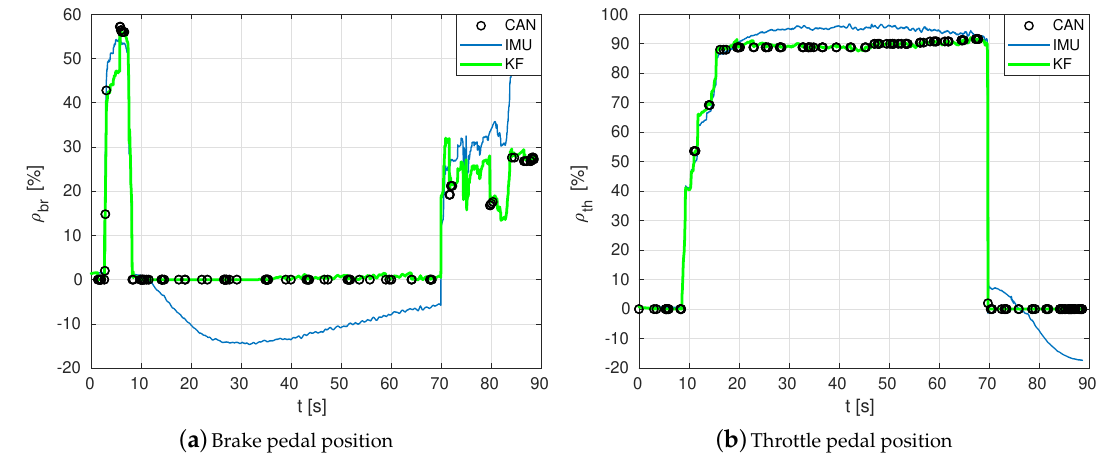
Figure 7. Estimation at a high rate of the positions of brake and throttle pedals (all in %).